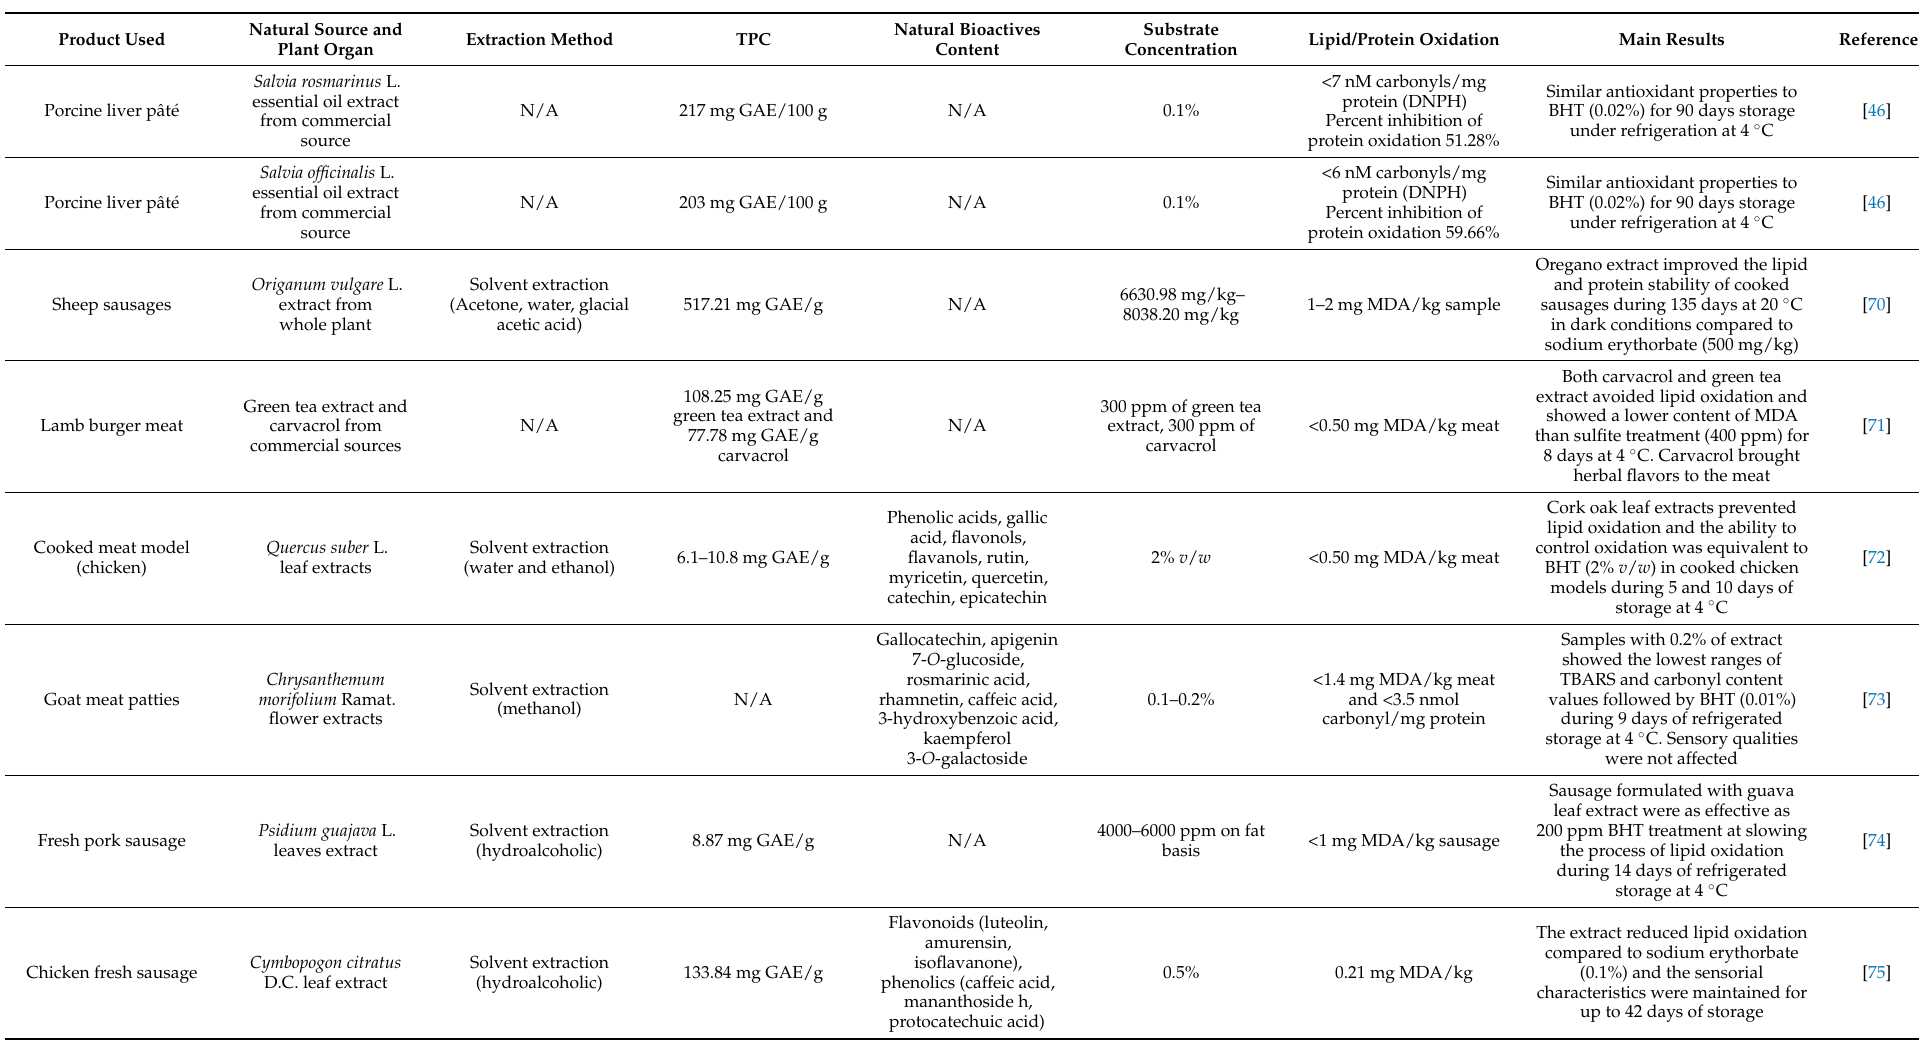
Table 1. Effect of natural antioxidants on lipid and protein oxidative stability of meat food matrices. MDA: malondialdehyde; N/A: not available; GAE: gallic acid equivalent; TPC: total phenolic